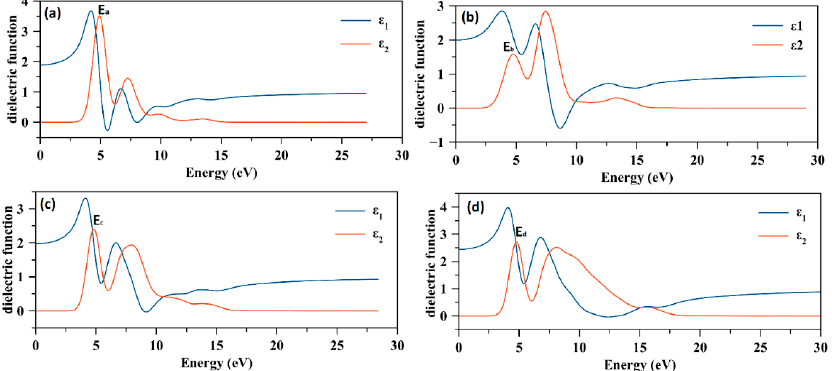
Figure 5. Variation in the real and imaginary parts of the dielectric function as function of energy of the different studied compounds: ( a ) (NH 3 (CH 2 ) 2 C 6 H 5 ) 2 [SnCl 6 ], ( b ) (C 6 H 10 N 2 )[SnCl 6 ], ( c ) (C 9 H 14 N) 2 [SnCl 6 ], and ( d ) (C 8 H 12 N) 2 [SnCl 6 ]. The first transition is the transition with the lowest energy from the valence band to conduction band. The TDOS and PDOS allow us to identify the different states that could participate in the first transition. Then, by using the selection rule ( ∆ l = 0, ∓ 1 (no 0 → 0 transition) [55,56] and based on structural study and dielectric function, it is possible to determine the nature of the first transition responsible for the energy band gap for each compound. The four structures ((NH 3 (CH 2 ) 2 C 6 H 5 ) 2 [SnCl 6 ], (C 6 H 10 N 2 )[SnCl 6 ], (C 9 H1 4 N) 2 [SnCl 6 ] and (C 8 H 12 N) 2 [SnCl 6 ]) each have the following orbital: H|s>,C|s>, C|p>, Cl|s>, Cl|p>Sn|s>, Sn|s>, N|s>, and N|p>. Based on the selection rule and partial density of states, we can find six possible transitions in the studied materials: H|s> ⇄ C|p>; H|s> ⇄ Cl|p>; H|s> ⇄ N|p>; Sn|s> ⇄ C|p>; Sn|s> ⇄ Cl|p>; Sn|s> ⇄ N|p>. To determine which one is the first transition, we determined the position of maximum of each partial state in the conduction band E c and valence band E v . Table 3 summarizes the position of partial states on the energy axis [54]. Table 4 presents the possible first transition and energy corresponding thereto, deduced from the dielectric function and the partial density of states. The energy of the first transition was determined directly from the curves (Figure 5). For the 𝛥𝐸 (cid:3049)⇆(cid:3030) , all possible combinations were calculated and only those which have energy close the 𝐸 (cid:3084) (cid:3118) were conserved (Table 4). Table 3. Position of the partial states on the energy axis for the different studied compounds. Energy